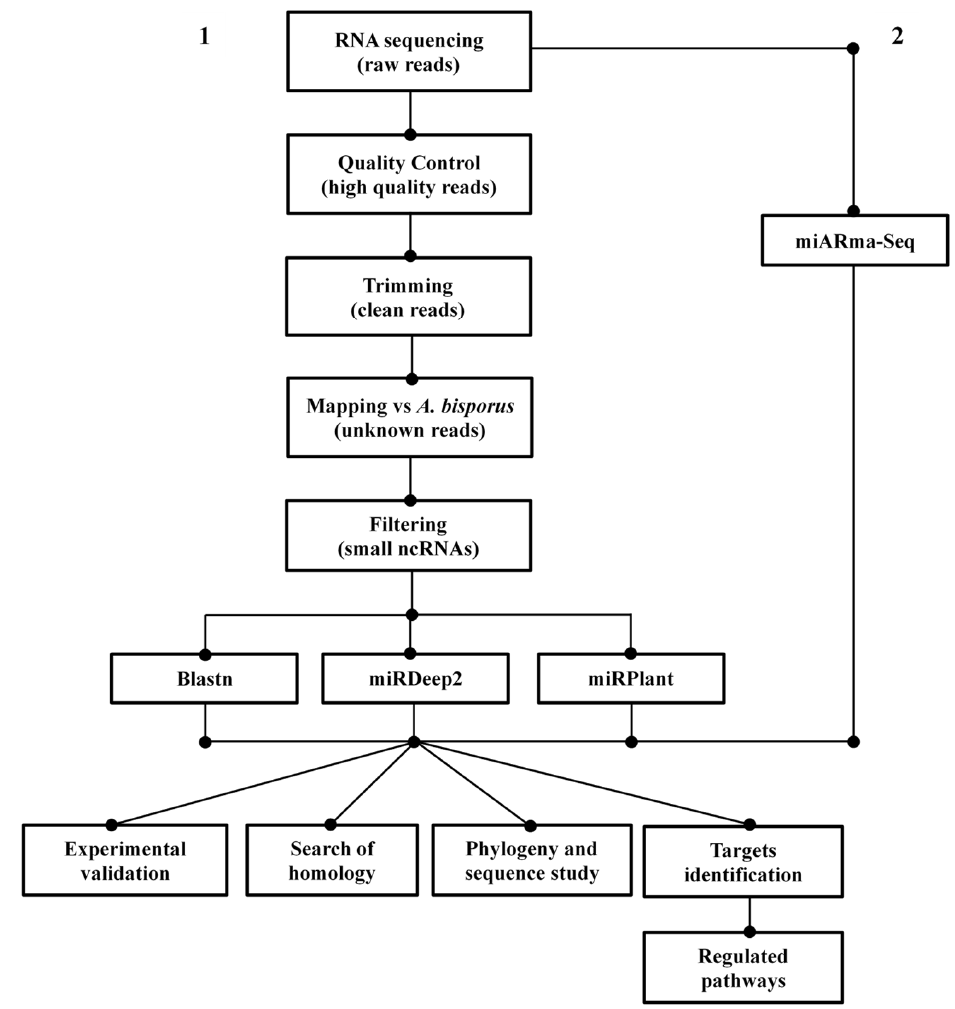
Figure 7. Flow-chart of the basic analysis process of milRNA sequencing data.